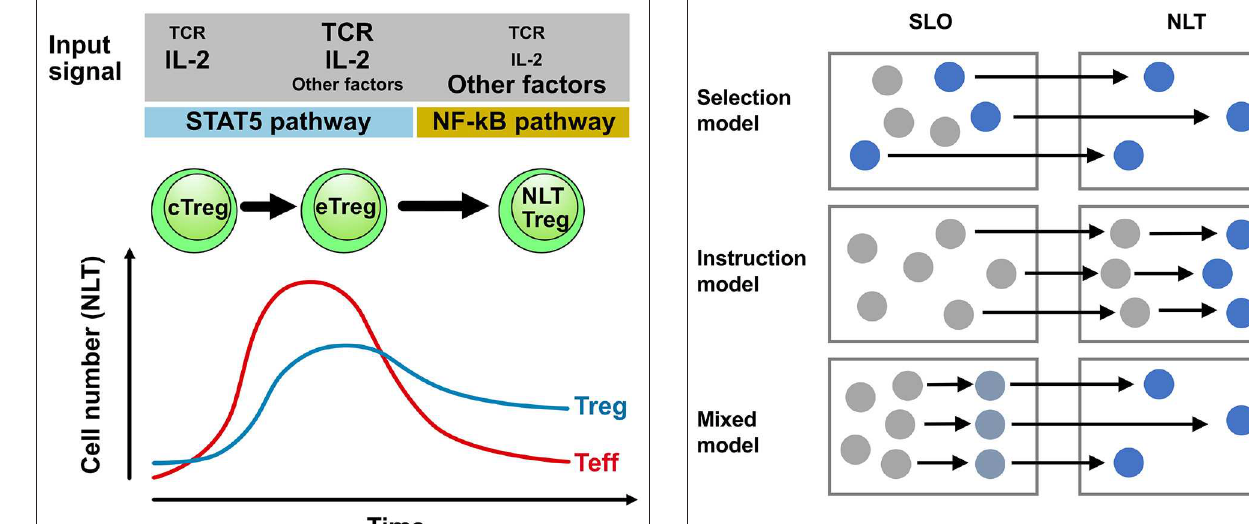
FIGURE 2 | Heterogeneity of Treg cells in NLTs. Treg cells are heterogeneous and the NLT milieu is likely an important determinant of this heterogeneity. However, it is unclear whether specific hard-wired subsets of Treg cells are selectively recruited from SLOs to distinct NLTs (selection model) or whether Treg cells that enter a given NLT are locally instructed to adopt specific properties and specialize according to a niche specific program (instruction model). Alternatively, some degree of imprinting might occur in SLOs during priming and further commitment of Treg cells to certain tissue specific properties might then take place in NLTs (mixed